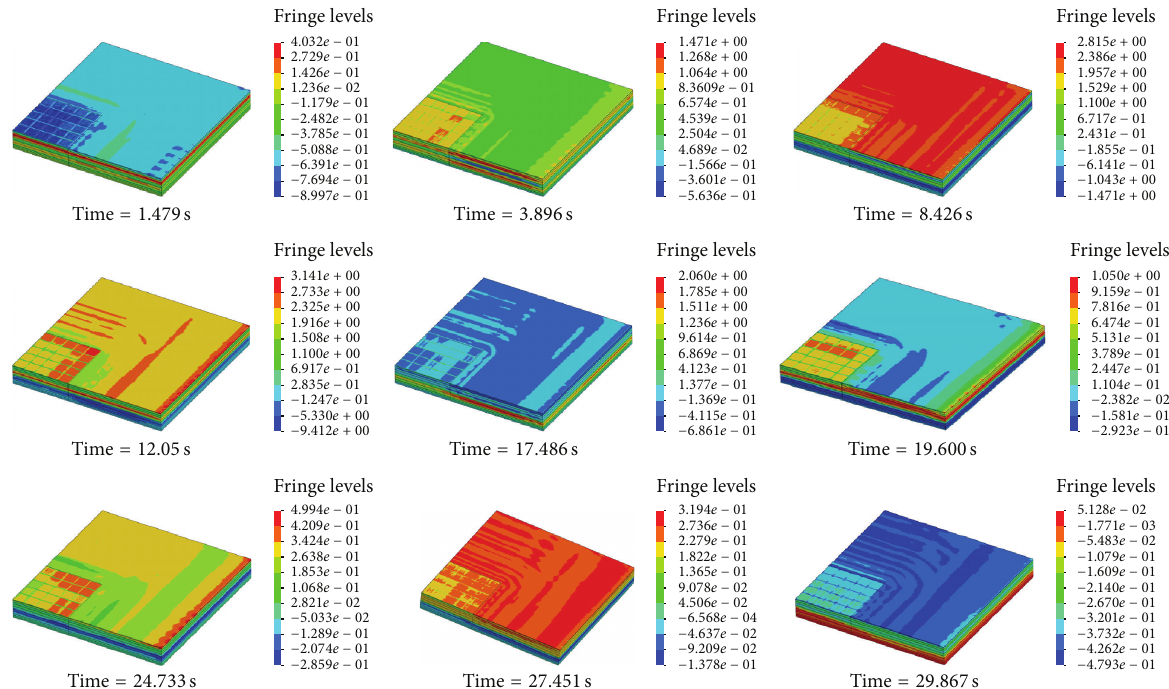
Figure 9: Instantaneous 𝑋 -component acceleration fields of the URBAN10-10 system (1/4 FE model, 𝐷 = 0.5 , MCH000, 𝑆𝑋 ).